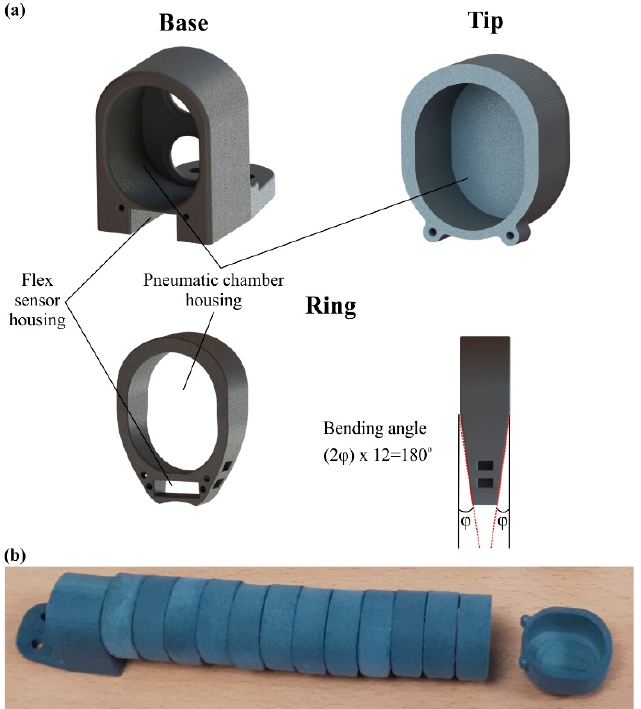
Figure 4. ( a ) 3D models of the base, ring, and tip; ( b ) 3D printed external covers made of PA12.